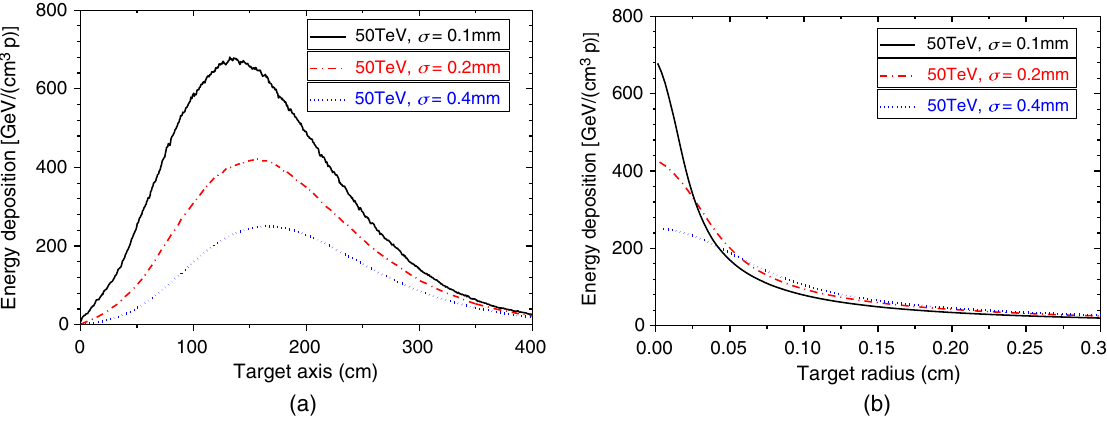
FIG. 13. Energy deposition per 50 TeV proton in a cylindrical graphite target for three different beam sizes (a) in the longitudinal direction at r ¼ 0 and (b) in the radial direction at L ¼ 135 . 8 cm for the beam size of 0.1 mm, L ¼ 155 . 3 cm for 0.2 mm, and L ¼ 164 . 3 cm for 0.4